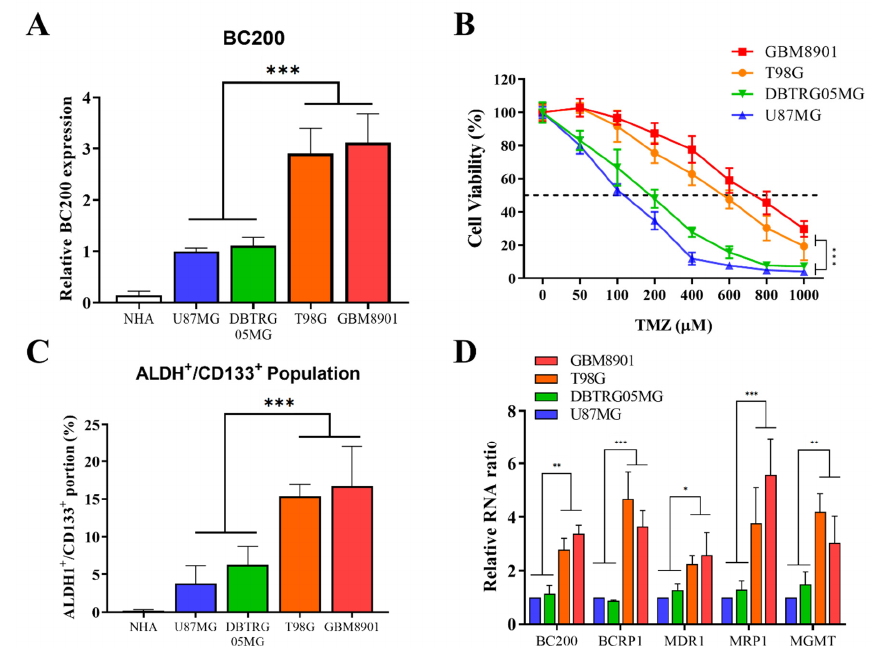
Figure 2. Di ff erential expression of BC200 RNA in GB cell lines. ( A ) The di ff erential expression of BC200 RNA in GB cell lines and normal human astrocytes are shown. ( B ) The viability of GB cells was analyzed through SRB assay 48h after TMZ (0–1000 µ M) treatment. ( C ) Flow cytometry analysis of the ALDH1 + /CD133 + portion in GB cell lines and normal human astrocytes. ( D ) The level of BC200, BCRP1, MDR1, MRP1 and MGMT in GB cell lines was analyzed using RT-qPCR. * p < 0.05, ** p < 0.01, and *** p < 0.001.